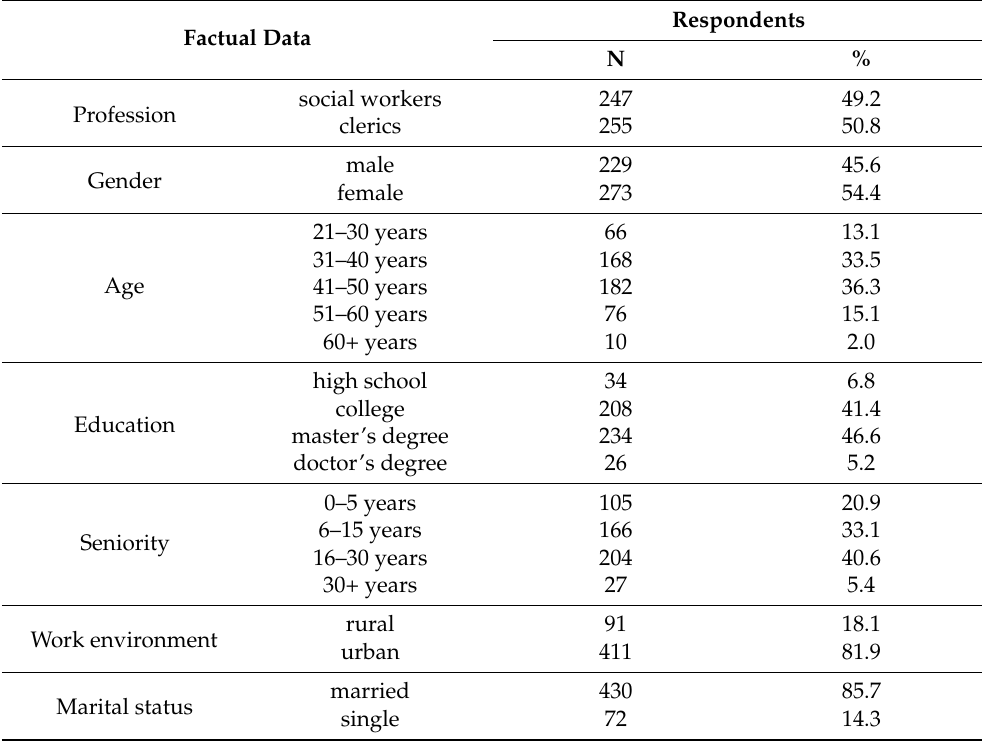
Table 1. Socio-demographic structure of the